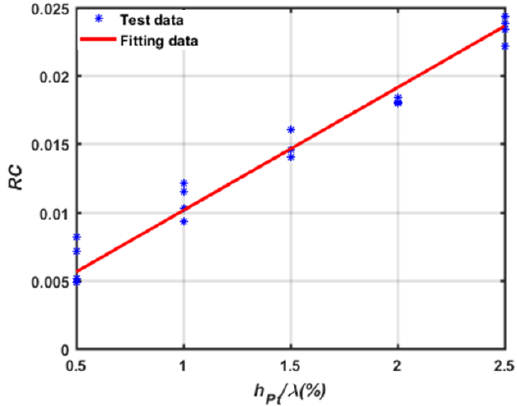
Figure 8 . RC of the prepared SAW device with various h pt /λ . Figure 8. RC of the prepared SAW device with various h pt / λ